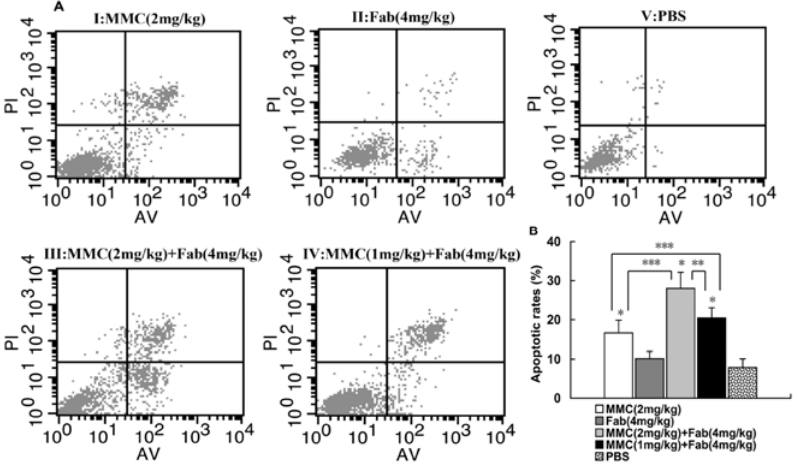
Figure 2. Flow cytometric analysis of the apoptosis of xenograft NPC tumor cells in five groups. After tumor tissues were excised and suspended, tumor cell suspensions were adjusted to a concentration of 1 × 10 6 cells/mL, and then resuspended in 250 μ L of binding buffer, and stained with staining solution containing Annexin V/FITC and PI. The cells were analyzed using a FACScan flow cytometer. A: Representative flow histograms showing the apoptosis of tumor cells. I: MMC (2 mg/kg); II: Fab (4 mg/kg); III: MMC (2 mg/kg) + Fab (4 mg/kg); IV: MMC (1 mg/kg) + Fab (4 mg/kg); V: PBS. B: Comparison of apoptotic rates of xenograft tumor cells in different groups. * P < 0.01 vs. group V;